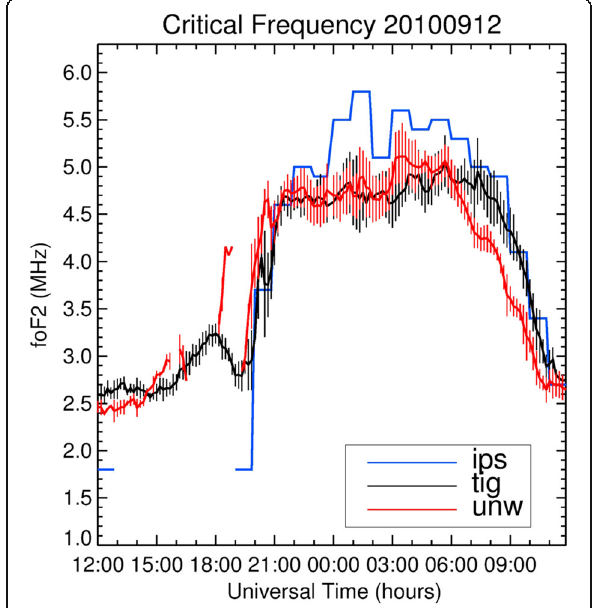
Fig. 24 Diurnal variation of foF 2 for 12 – 13 September 2010 calculated